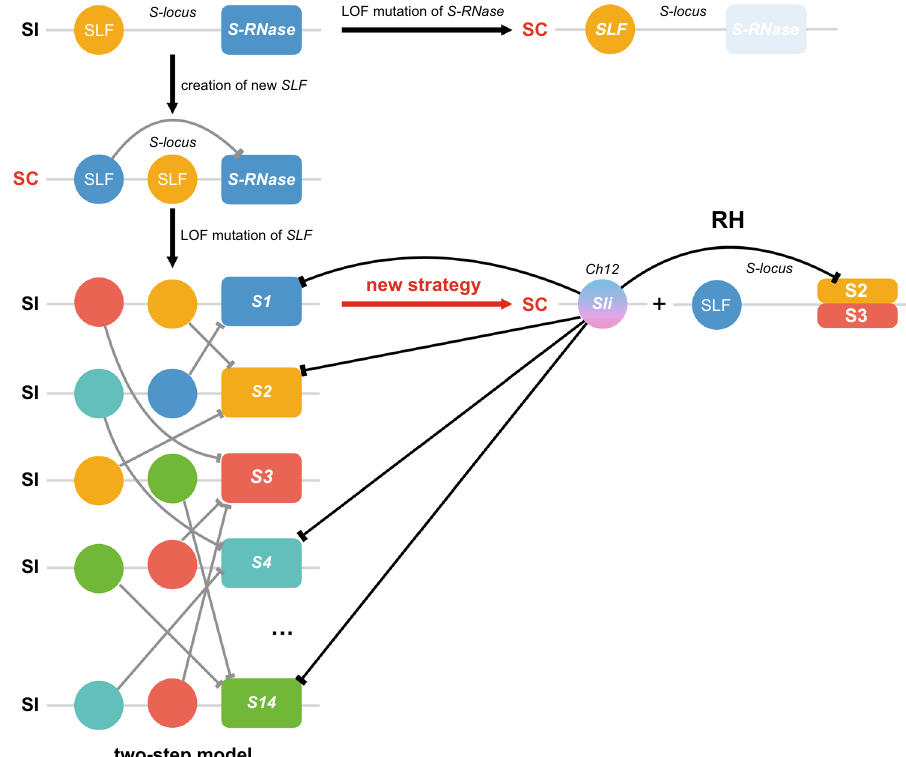
Fig. 4 A model depicting the evolution of Sli in diploid potatoes. In Solanaceae, a two-step model was proposed to explain the evolution of new SLFs to confer SC to self-incompatible plants, by fi rst interacting with the self S-RNase. Then, the reverse from SC to SI is induced by the loss of ability for these new SLFs to interact with the self S-RNase. The appearance of Sli at the non-S-locus region represents a new strategy, in addition to the loss-of-function (LOF) mutations of S-RNases , to confer SC to self-incompatible lines. The S-haplotypes in RH are StS-RNases2 and 3. Negative regulations of the multiple StS-RNases by the nonself SLFs or Sli are indicated by the barred lines, which constitute the molecular basis to impart SC to RH and other self-incompatible potatoes. SI self-incompatibility, SC self-compatibility, S1 – S14 14 types of S-RNases identi fi ed from self-incompatible diploid potatoes, Ch